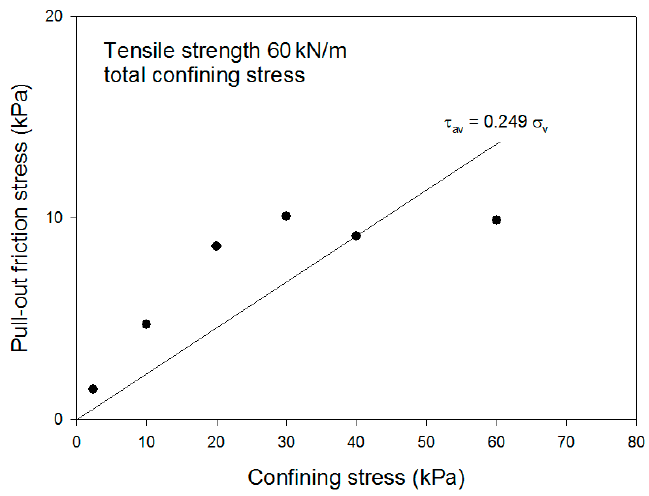
Figure 8. Relationship curve between confining stress and pullout frictional stress by total confining stress (T g = 60 kN/m).